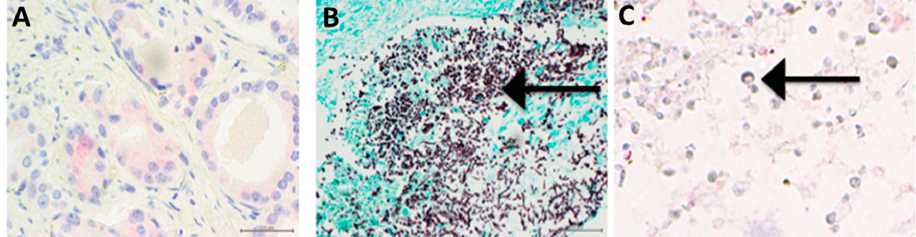
amount of fungi (black) (200 × ). ( C ) Same area as B, stained for PTX3. There are numerous yeast cells seen (arrow) and ghosts of filamentous forms of Candida that are translucent and not stained by antibody to PTX3 (400 ×